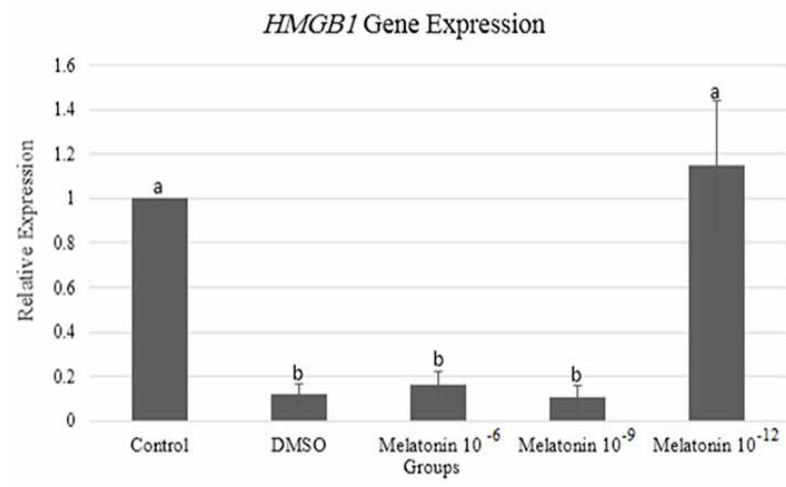
FIGURE 3 – Relative expression levels of the HMGB1 gene expression in mice blastocyst s Relative expression levels of the HMGB1 gene in blastocysts cultured with different doses of melatonin and without melatonin. The mRNA levels of HMGB1 were analyzed with real-time PCR and mRNA levels were normalized to Hprt mRNA level. The relative levels of mRNA were analyzed by REST 2009 Software (QIAGEN). a, b Numbers with different lowercase letters differ significantly (P<0.05). Data were presented as mean ±